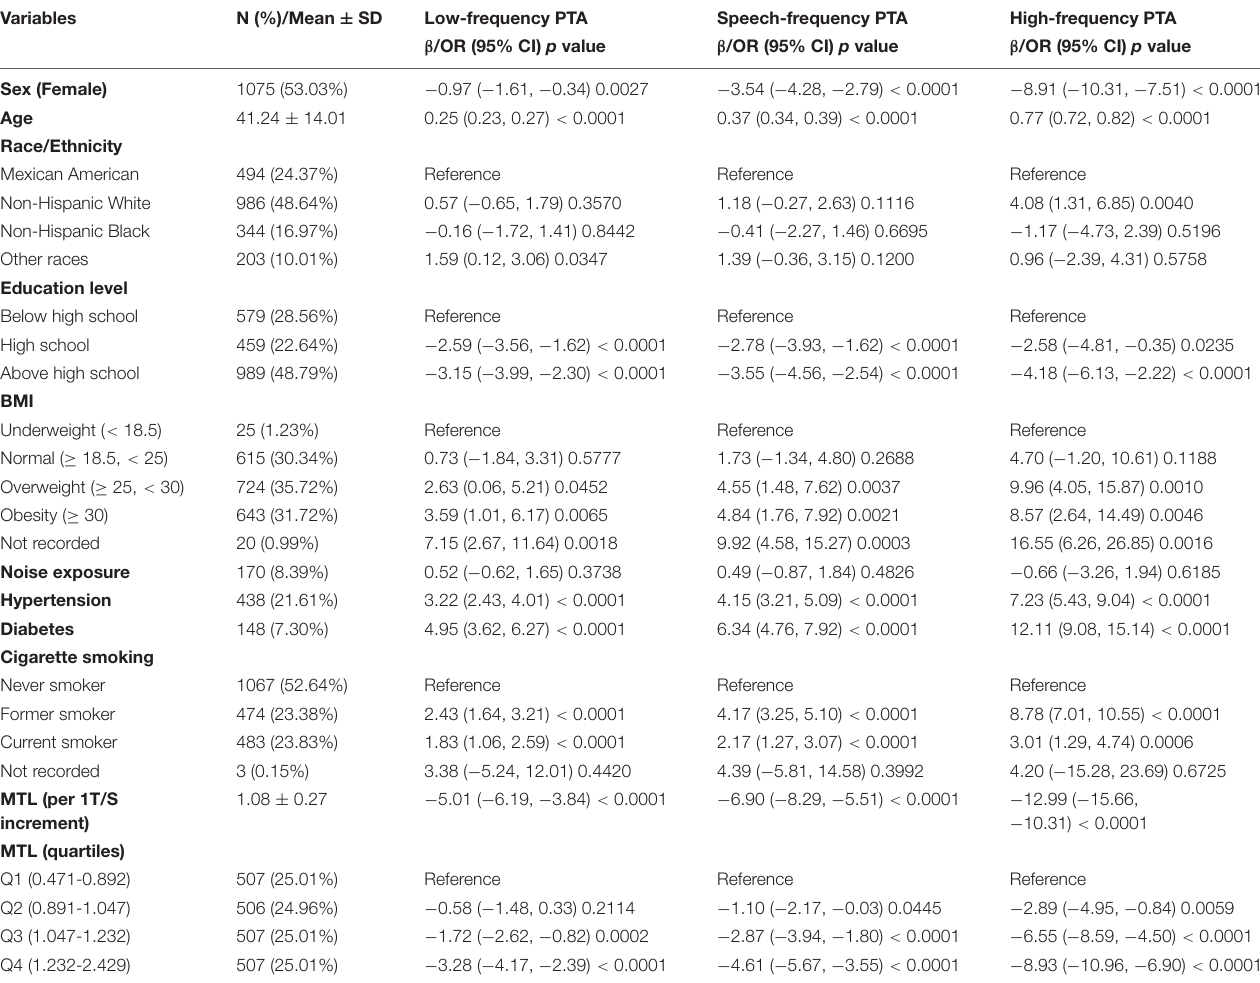
TABLE 2 | The univariate analysis of comparison of variables in hearing threshold